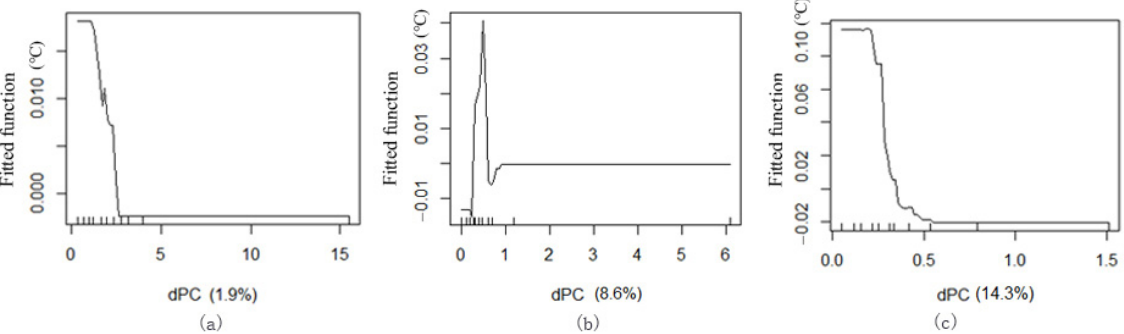
Figure 13. Scatter diagram of the GWd factor and its corresponding Ta distribution: ( a ) block N1, ( b ) block N2 and ( c ) block N3. Although the Ta values of different green corridor segments in the three blocks are affected by other spatial factors, such as dPC, the GWd and Ta of green corridors are correlated, i.e., if the width of green corridors is larger, the Ta is lower.